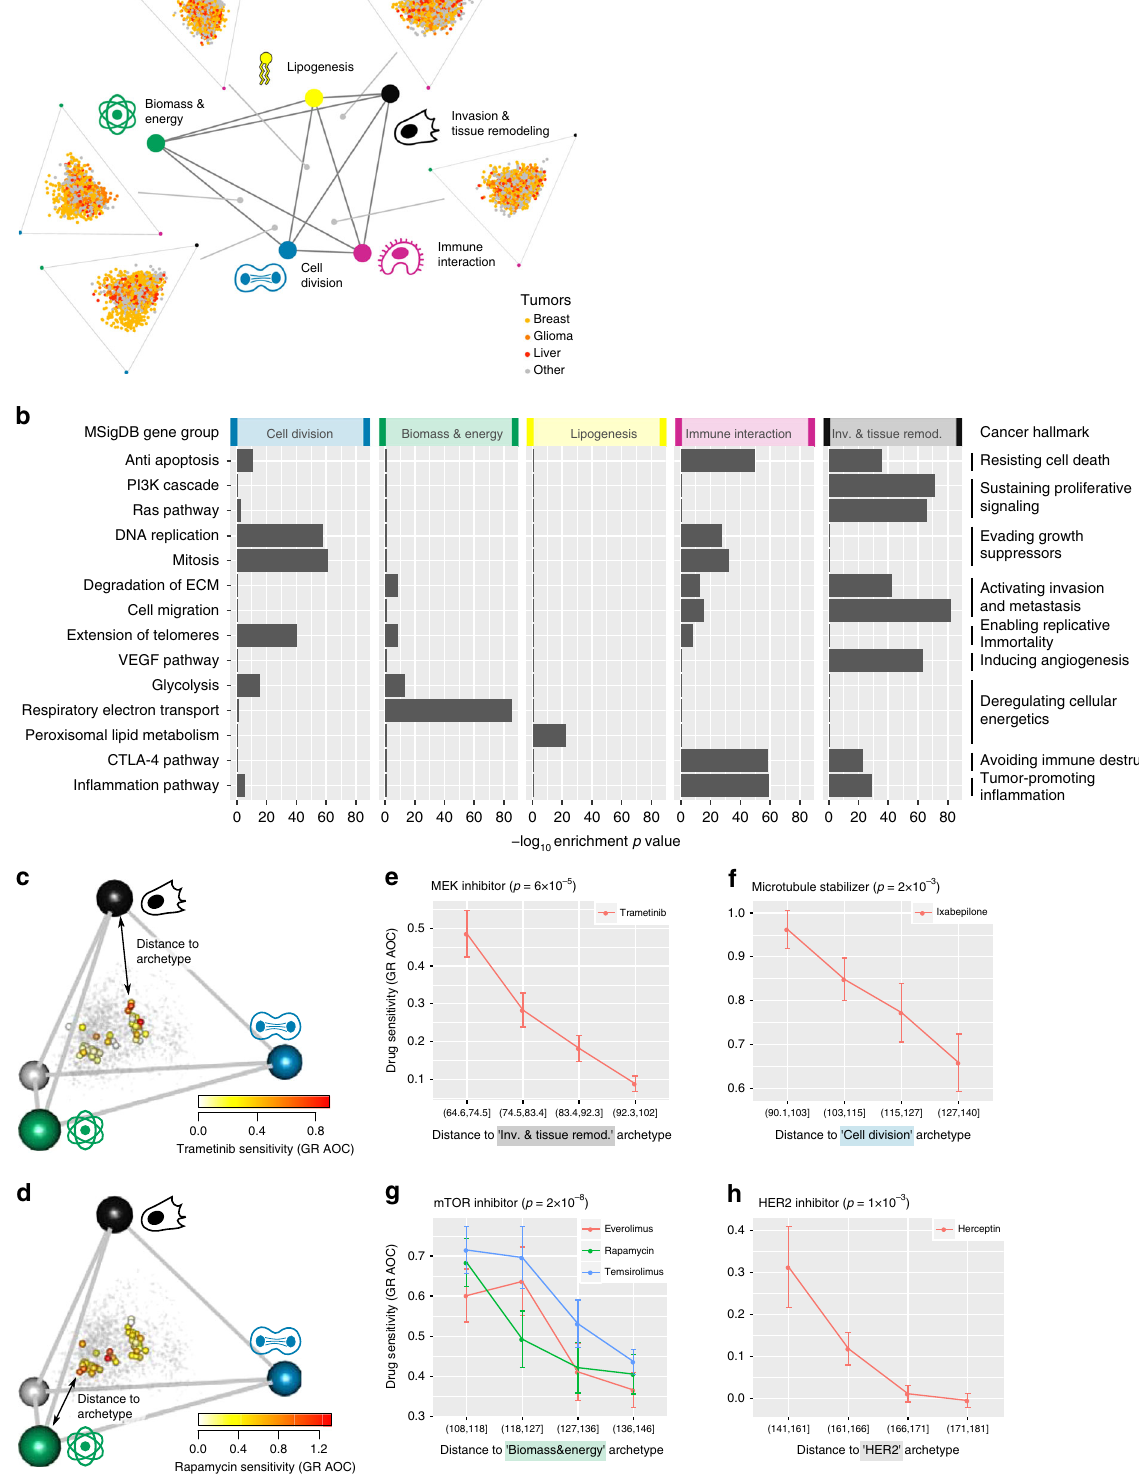
The tasks for each tissue type are indicated in Table 1, and color coded on the archetypes of Fig. 1d. Each tissue type seems to show a trade-off between 3 – 5 universal tasks (Table 1, Supplementary Fig. 2D). Breast cancer shows three universal archetypes (division, invasion, biomass and energy) and a fourth one enriched with HER2-positive tumors ( p < 10 − 8